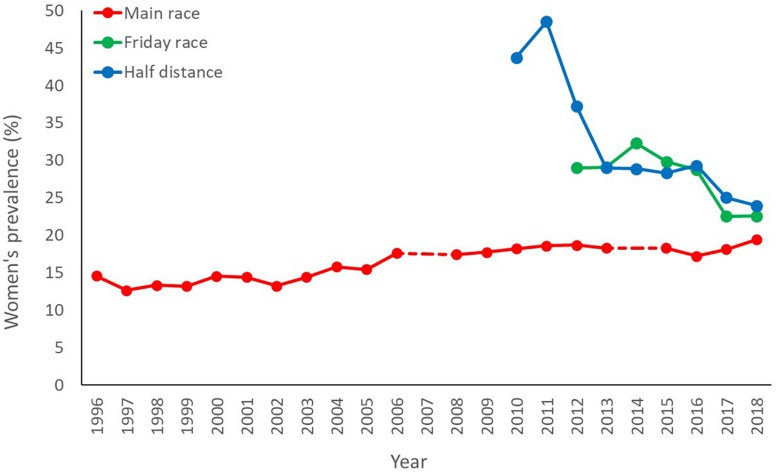
Prevalence of women in the main ski race, Friday race, and half-distance race, expressed as a percentage (%) of total participants registered. The main ski race was canceled in 2007 and 2014, as marked by a discontinuous line.